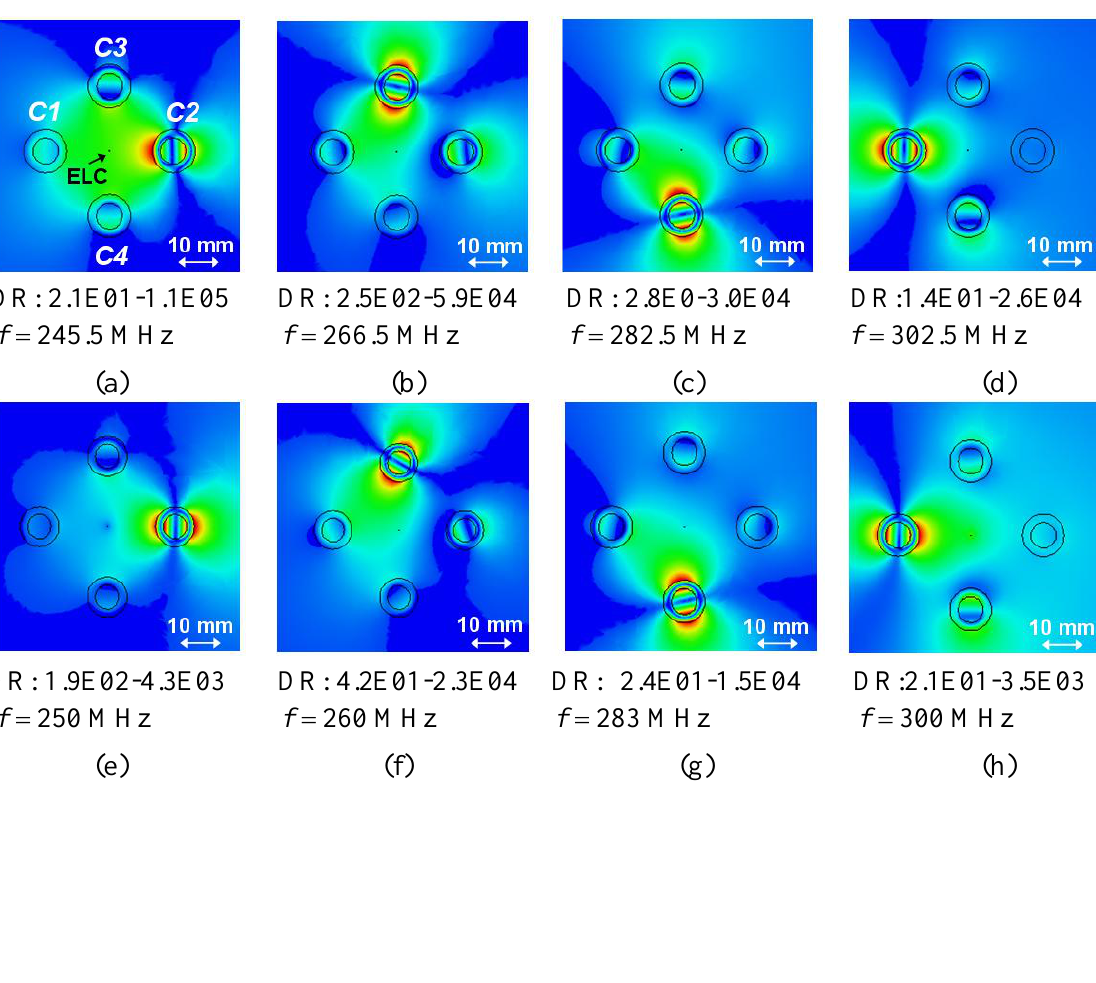
Figure 7. The magnitude of the electric field of the 4-cylinder structure for the separation distance d = 40 mm for different frequencies. The ELC is located at )0,mm2/(),( o d  1, Coss